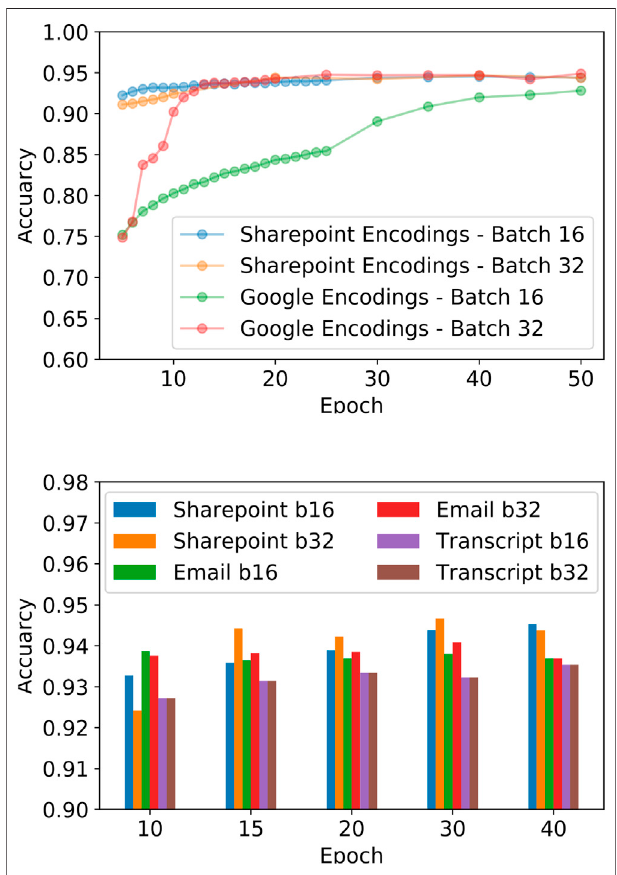
FIGURE2| Comparisonoftestsetaccuracyusingdifferentembeddings and batch sizes.